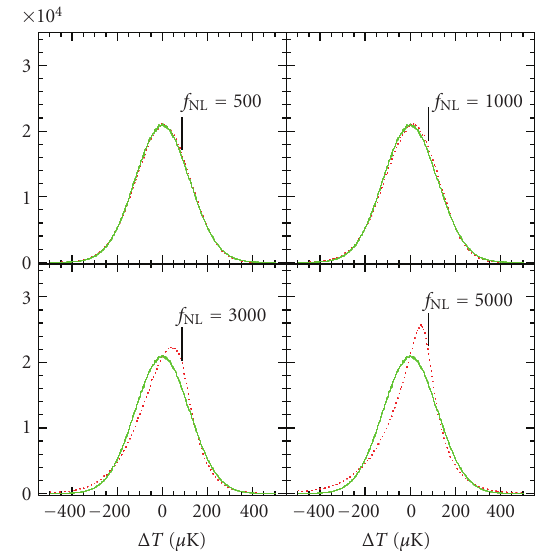
Figure 13: Probability density function of temperature pixel from local primordial non-Gaussian CMB maps, obtained with the “exact” simulation algorithm described in Section 3.10.1. Di ff erent , in order to give an panels show the result for di ff erent values of f loc NL idea of the order of magnitude of the signal that one wants to detect. For f NL < 1000 the non-Gaussianity is too small to be seen in these to be (cid:2) plots. Note that WMAP constrains f loc NL